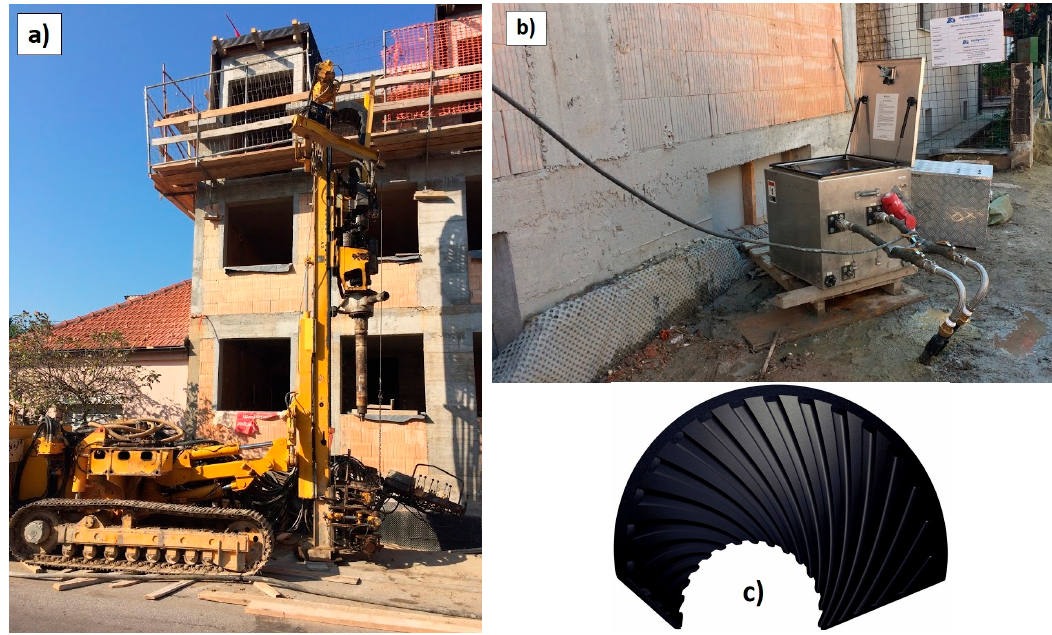
Figure 3. ( a ) Drilling of the BHEs; ( b ) performing the thermal response test; ( c ) TurboCollectorTM pipe wall.